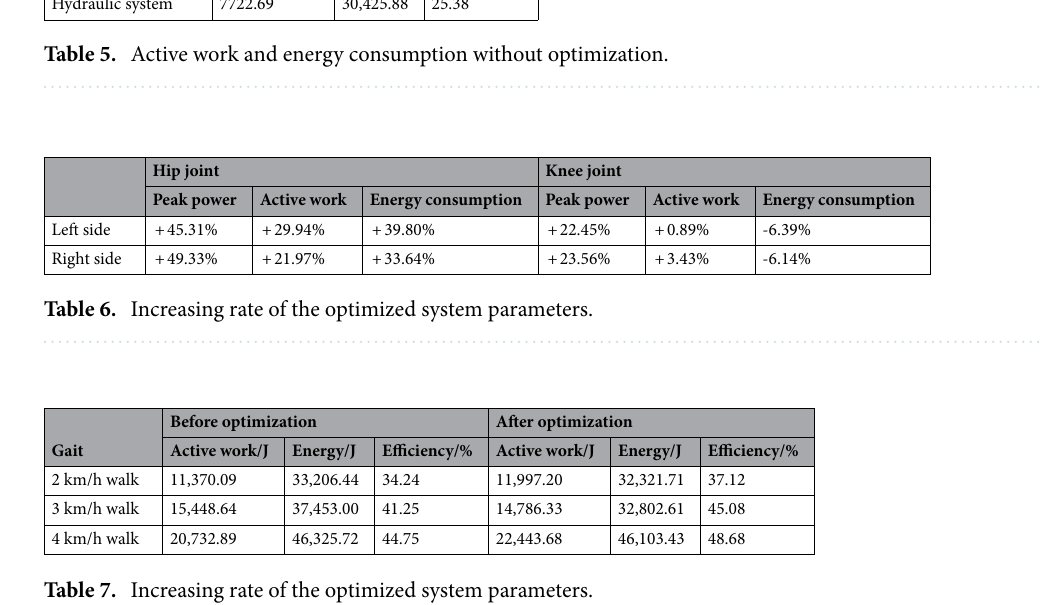
Table 7. Increasing rate of the optimized system